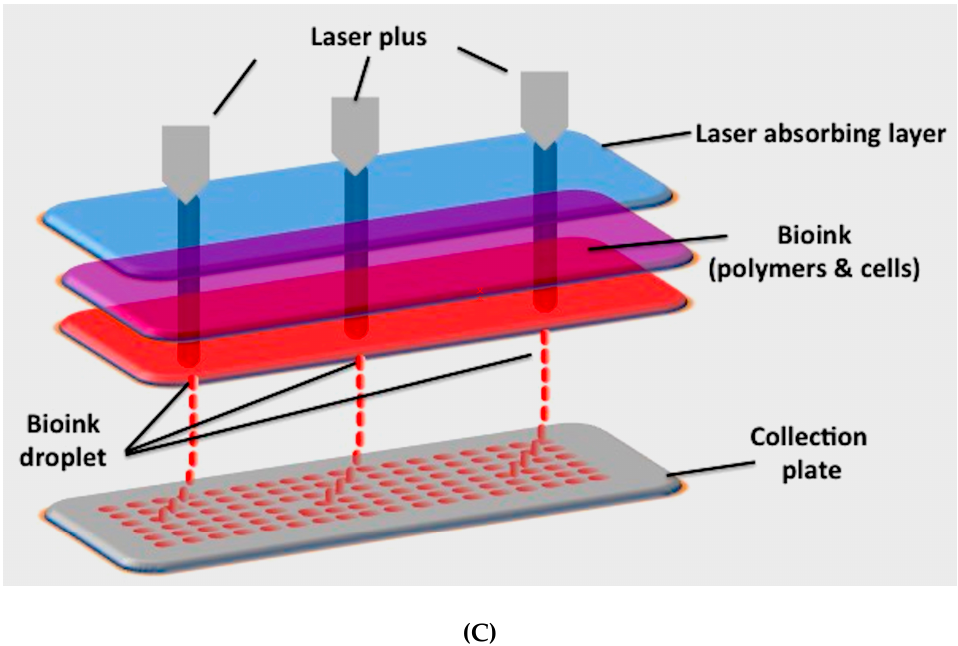
Figure 1. Schematic diagrams of three major types of three-dimensional (3D) printing technologies: ( A ) inkjet-based bioprinting (a: heater; b: piezoelectric actuator); ( B ) extrusion-based printing (a: pneumatic; b: piston); ( C ) laser-assisted bioprinting [33].